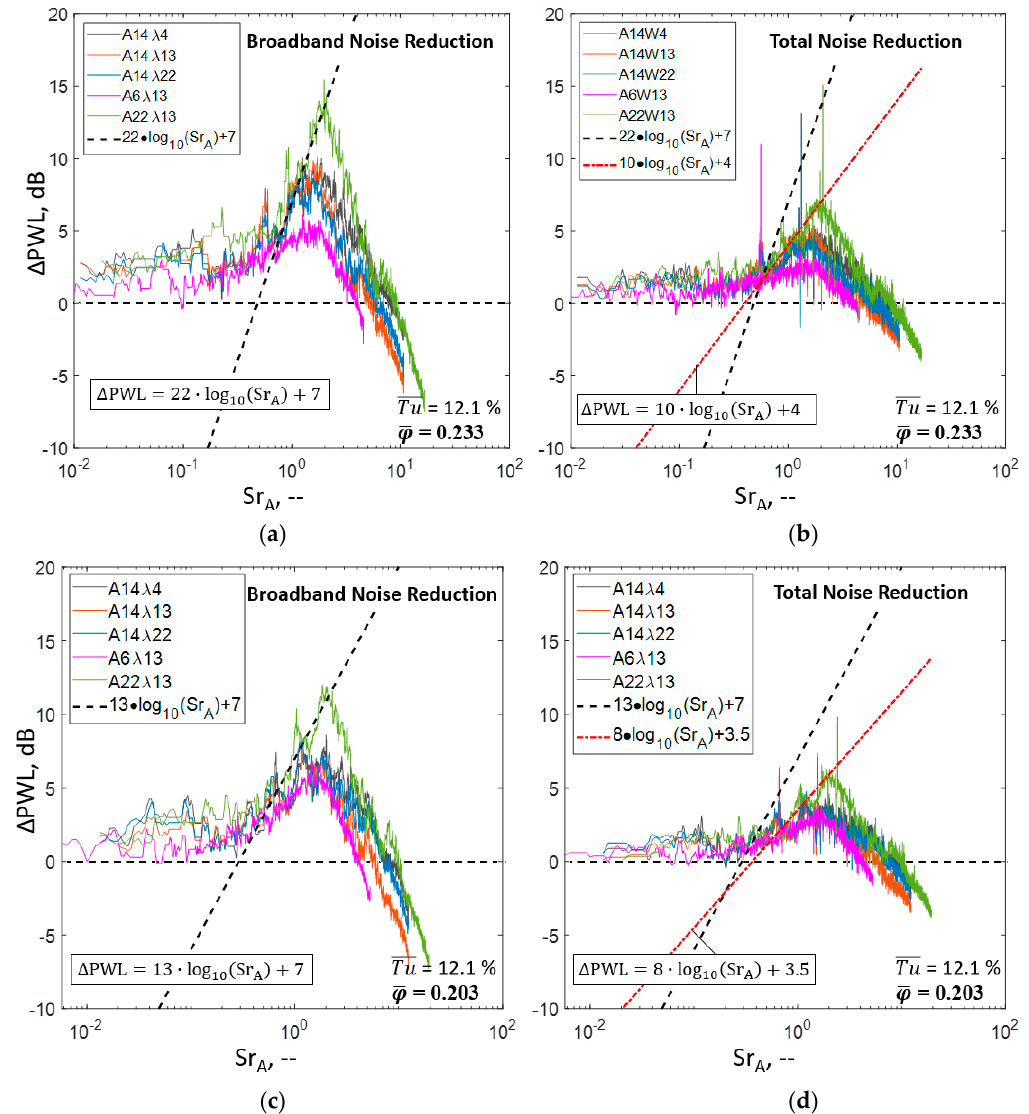
Figure 13. Juxtaposition of spectral noise reduction Δ PWL for broadband and total noise while varying the serration parameters as well as the point of operation. ( a ) Broadband reduction at 𝜑(cid:3364) = 0.233%; ( b ) Total reduction at 𝜑(cid:3364) = 0.233%; ( c ) Broadband reduction at 𝜑(cid:3364) = 0.203%; ( d ) Total reduction at 𝜑(cid:3364) = 0.203%.